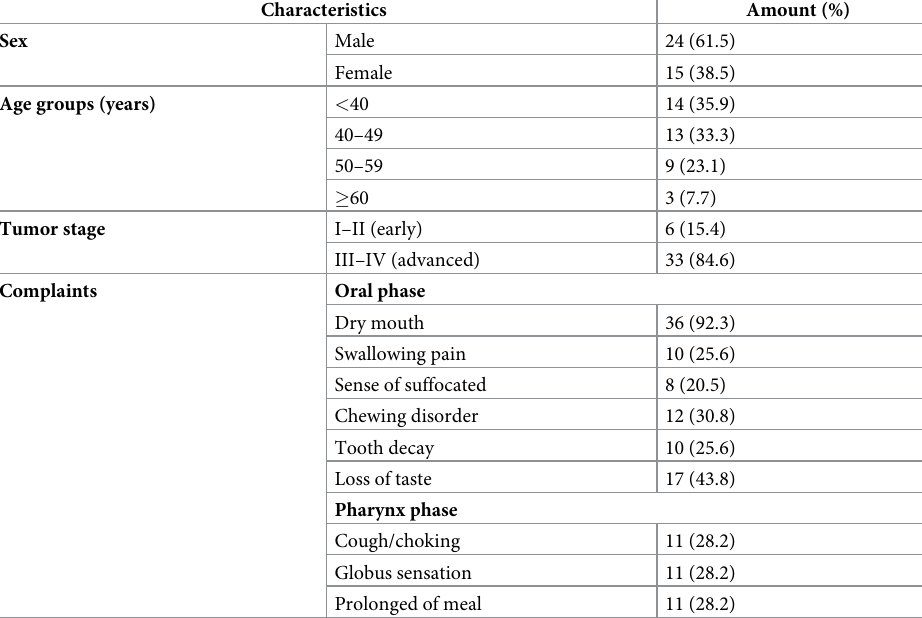
Table 1. Baseline demographic and clinical characteristics of the patients.